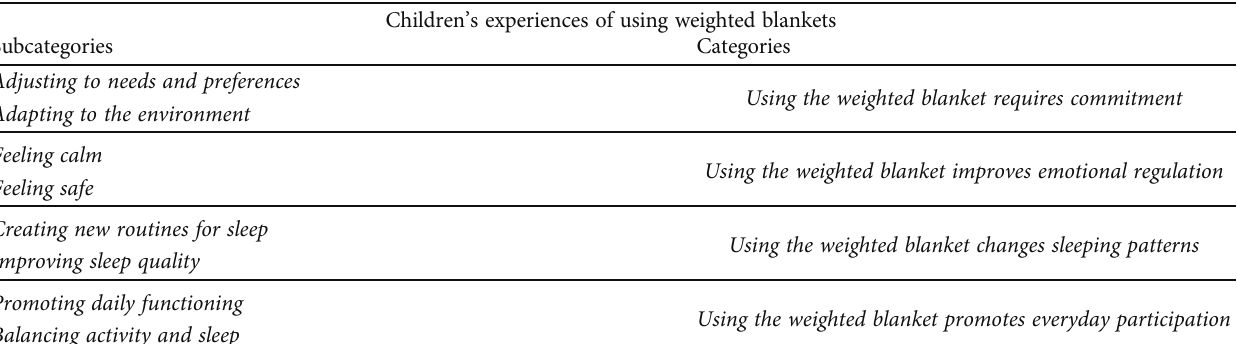
Table 2: The subcategories and categories describing children ’ s experiences of using weighted